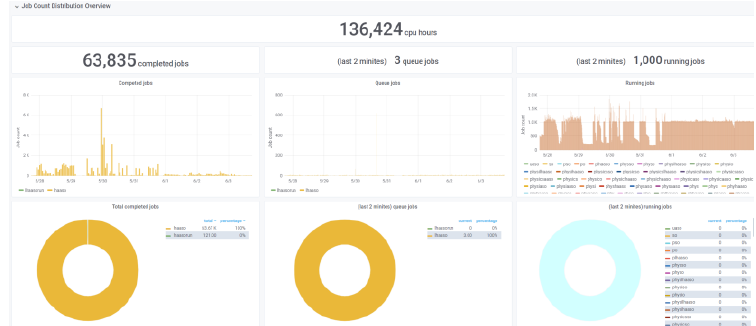
Figure 8. The completed jobs and consumed CPU hours from May 28 to June 3,